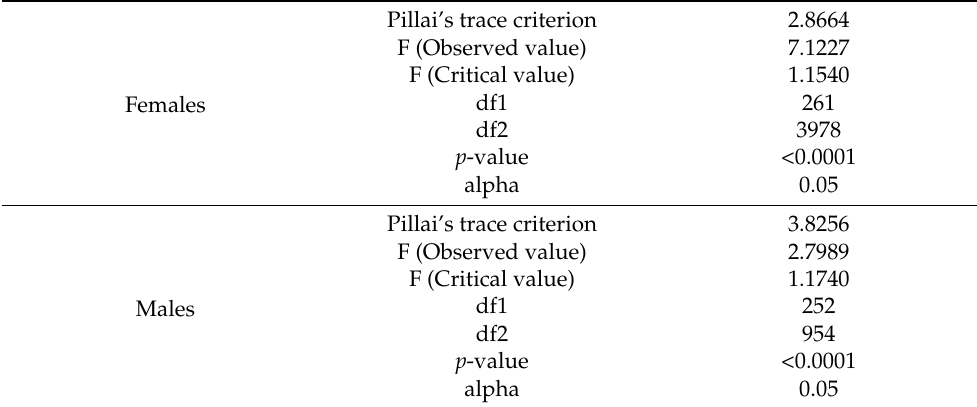
Table 3. Summary of the results of Pillai’s trace of equality of covariance matrices of canonical discriminant functions.